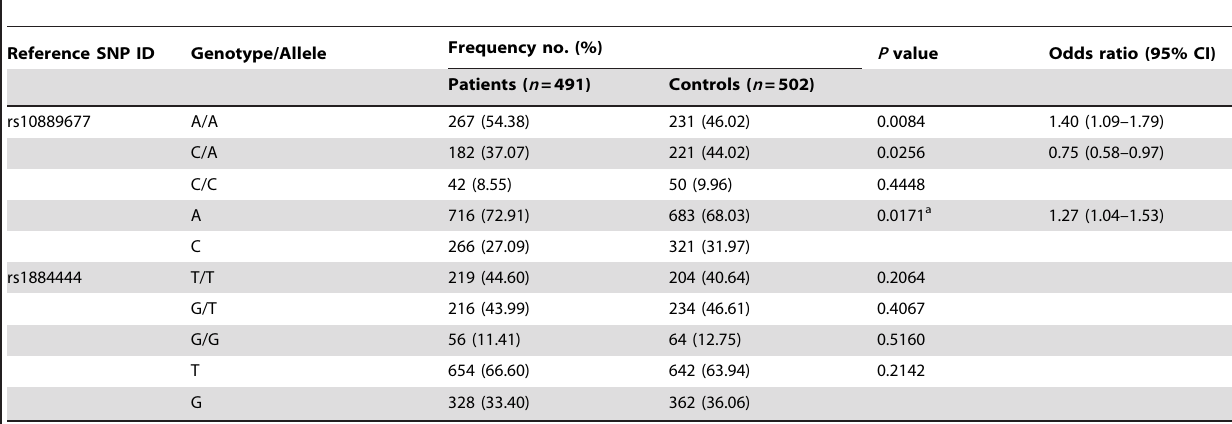
Table 1. Frequencies of genotypes and alleles of two IL23R SNPs in breast cancer patients and